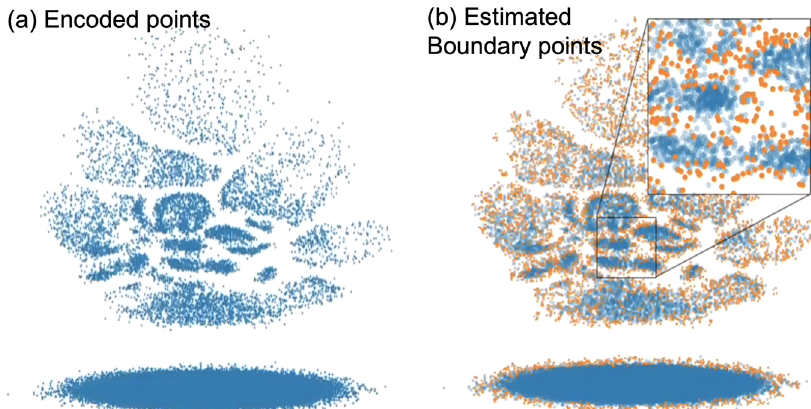
Fig. 3 Example of boundary point estimation. a 96,000 diffraction patterns encoded into 2D space. b The same encoded patterns are in blue, with 5000 sampled boundary point candidates shown in orange. A sub-region is highlighted in the